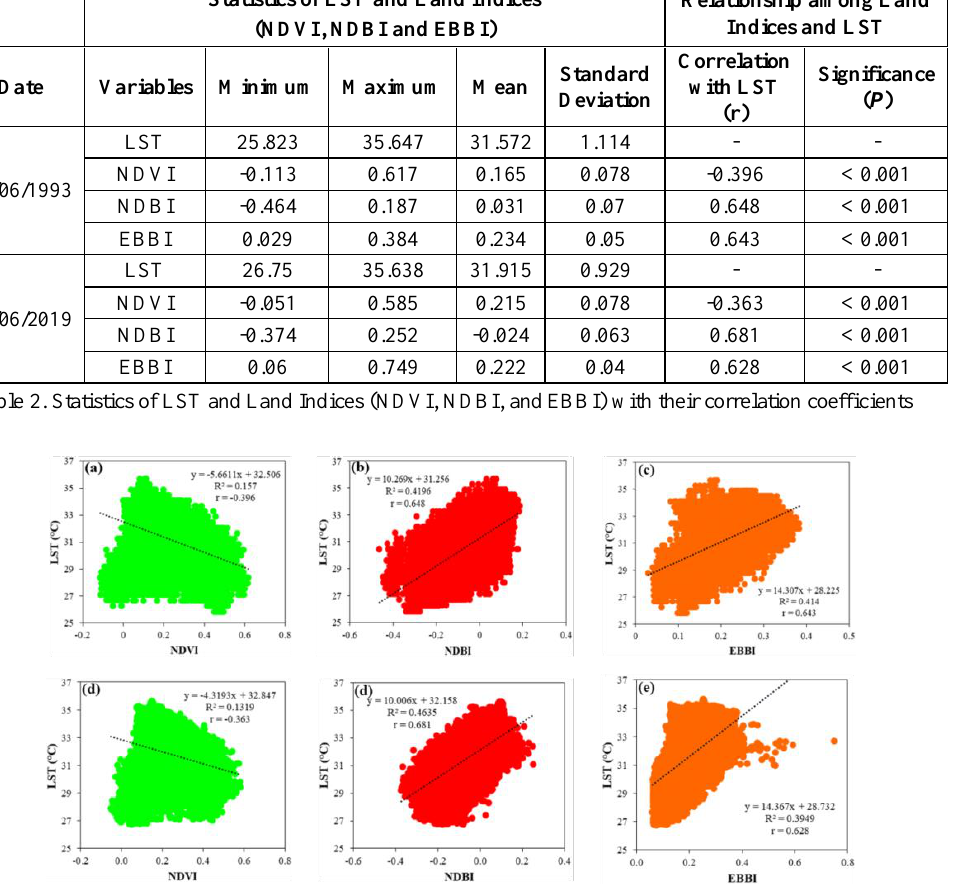
Figure 3. Scatter plots of LST and Land Indices for 09/06/1993: (a) LST vs NDVI, (b) LST vs NDBI, (c) LST vs EBBI; for 01/06/2019: (d) LST vs NDVI, (e) LST vs NDBI, (f) LST vs